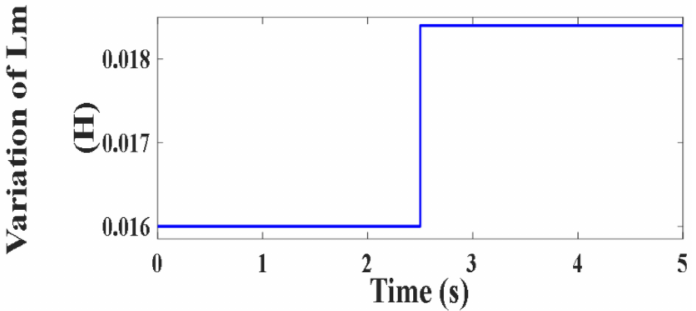
Figure 180. Variation of L m